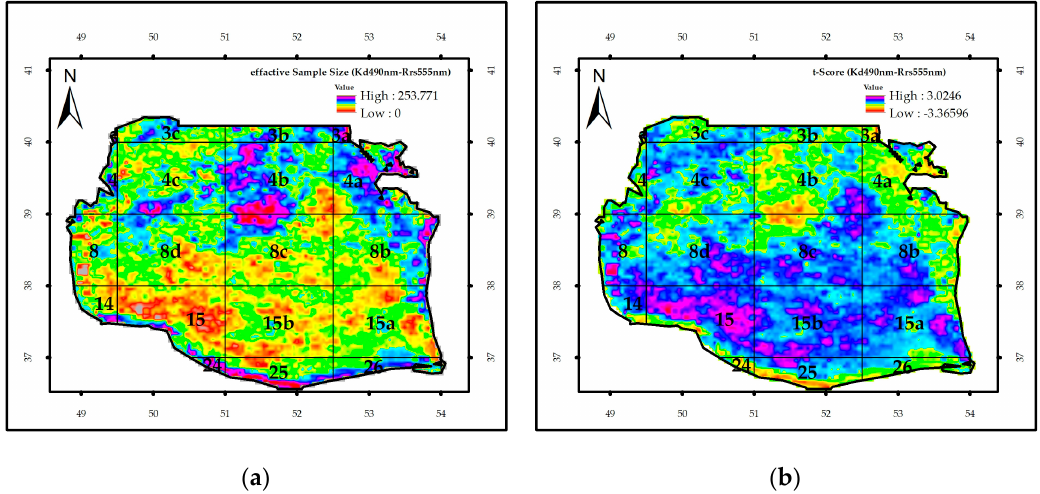
Figure 11. The image of effective sample size (n e ) ( a ) and the value of t -test for the regression of Kd_490nm and Rrs_555nm ( b ) in the SCS.